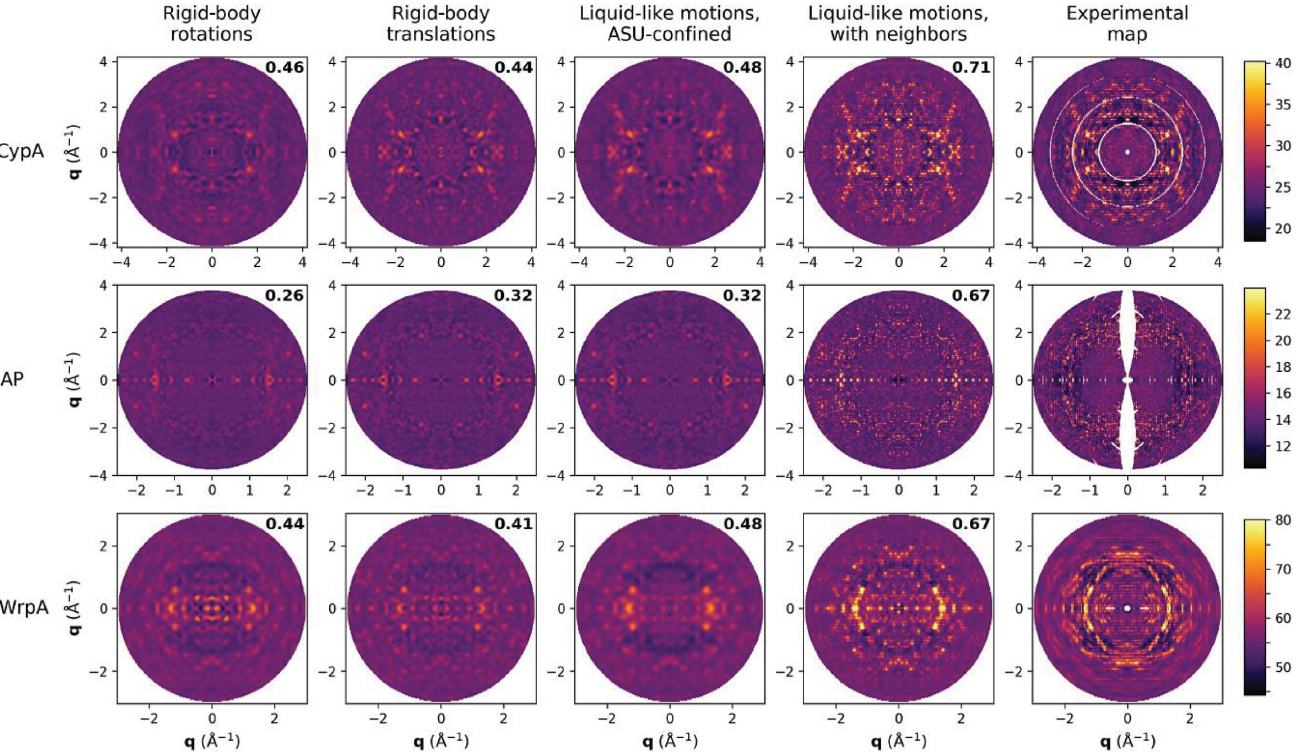
Figure 4 Comparison of models of rigid-body and liquid-like motions. For the indicated model, parameters that tune the disorder were fitted to maximize overall correlation with the experimental map. The predicted 0 kl planes for the best-fit maps are shown, with the experimental 0 kl planes displayed in the rightmost column for comparison. The overall CC between the experimental map and each predicted map is noted in black. As with Fig. 1, the color scales span a partial range of the voxel intensities to improve visual